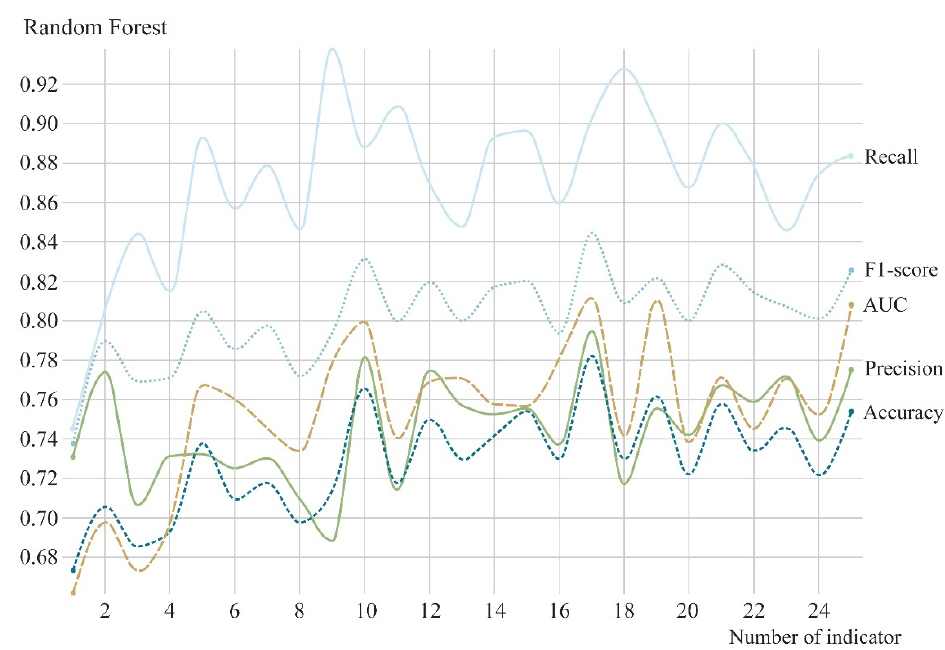
Figure 7. Parameters of the random forest models with different numbers of indicators.